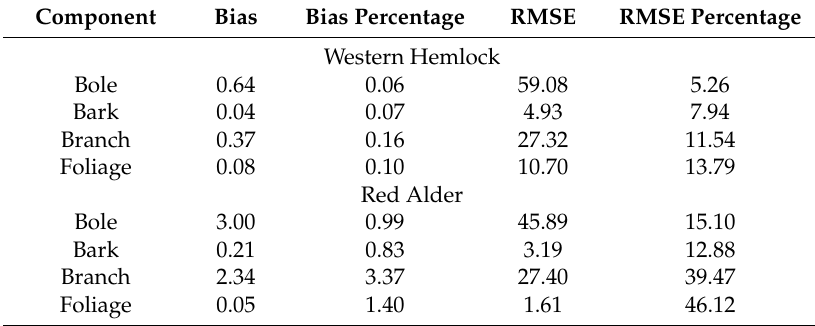
Table 10. Evaluation statistics (Bias, bias percent, RMSE, and RMSE percent) in component biomass estimation in Western hemlock and red alder trees using multinomial log-linear